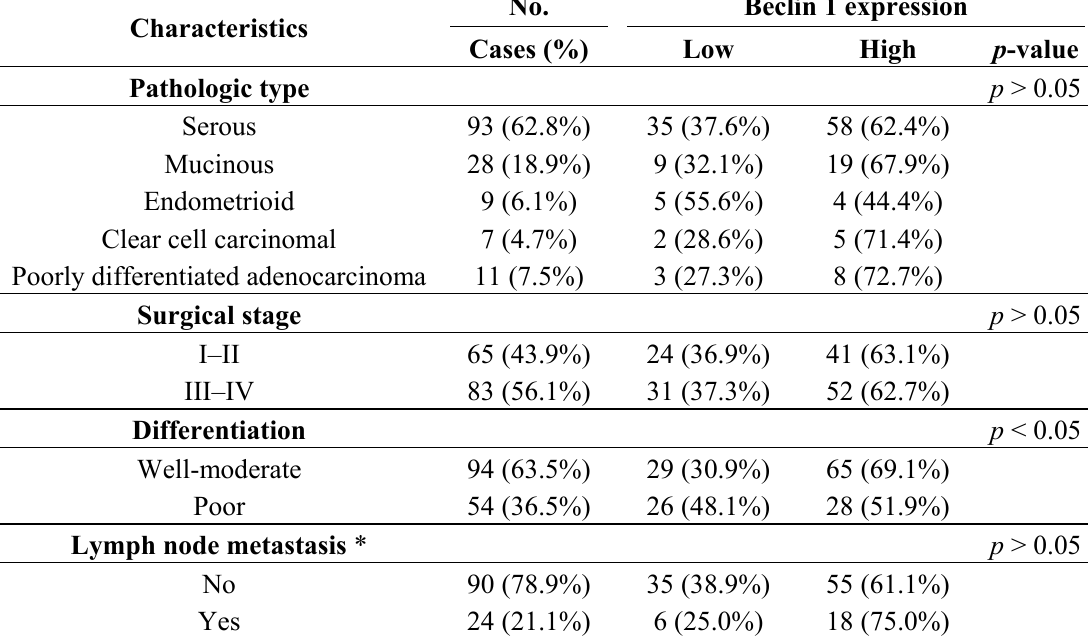
Table 2. Relationships between the expression of Beclin 1 protein and clinicopathological characteristics of 148 patients with malignant ovarian cancer.